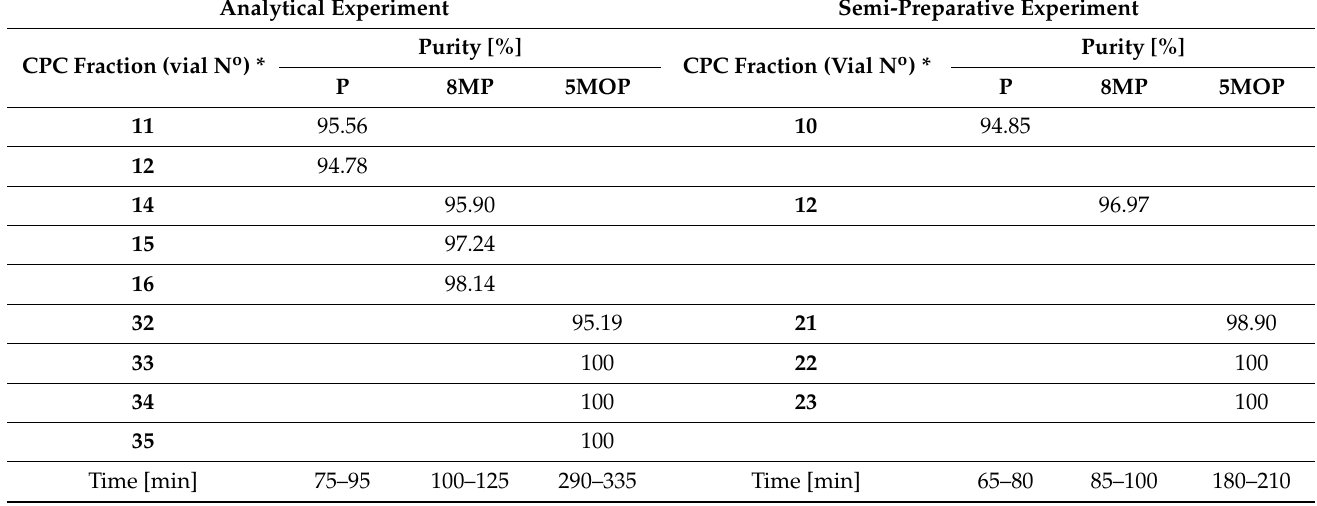
Table 3. Purity [%] (assayed by HPLC-DAD) of methoxyfuranocoumarins, isolated from P. tauricum fruits, by analytical and semi-preparative CPC in the biphasic system n Hp:E:M:W (5:2:5:2, v / v / v / v